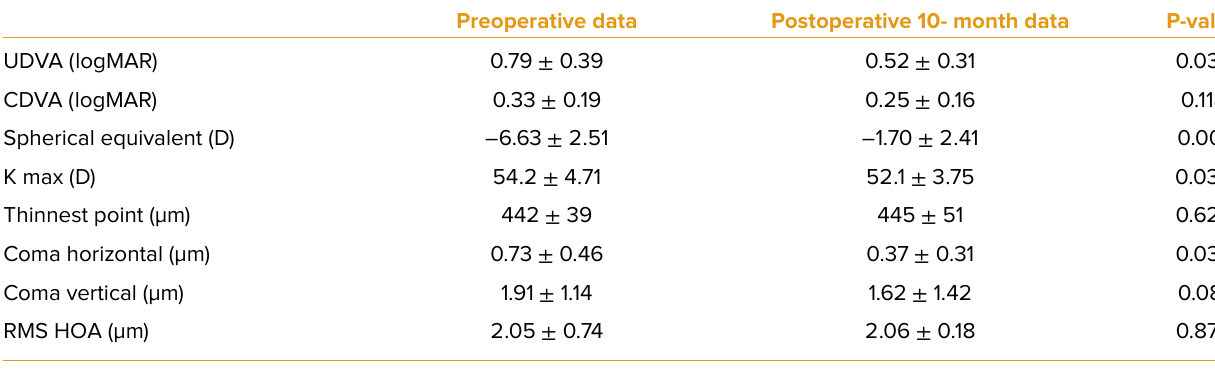
Table 4. Comparison of parameters in the MyoRing and MyoRing + CXL groups after 10